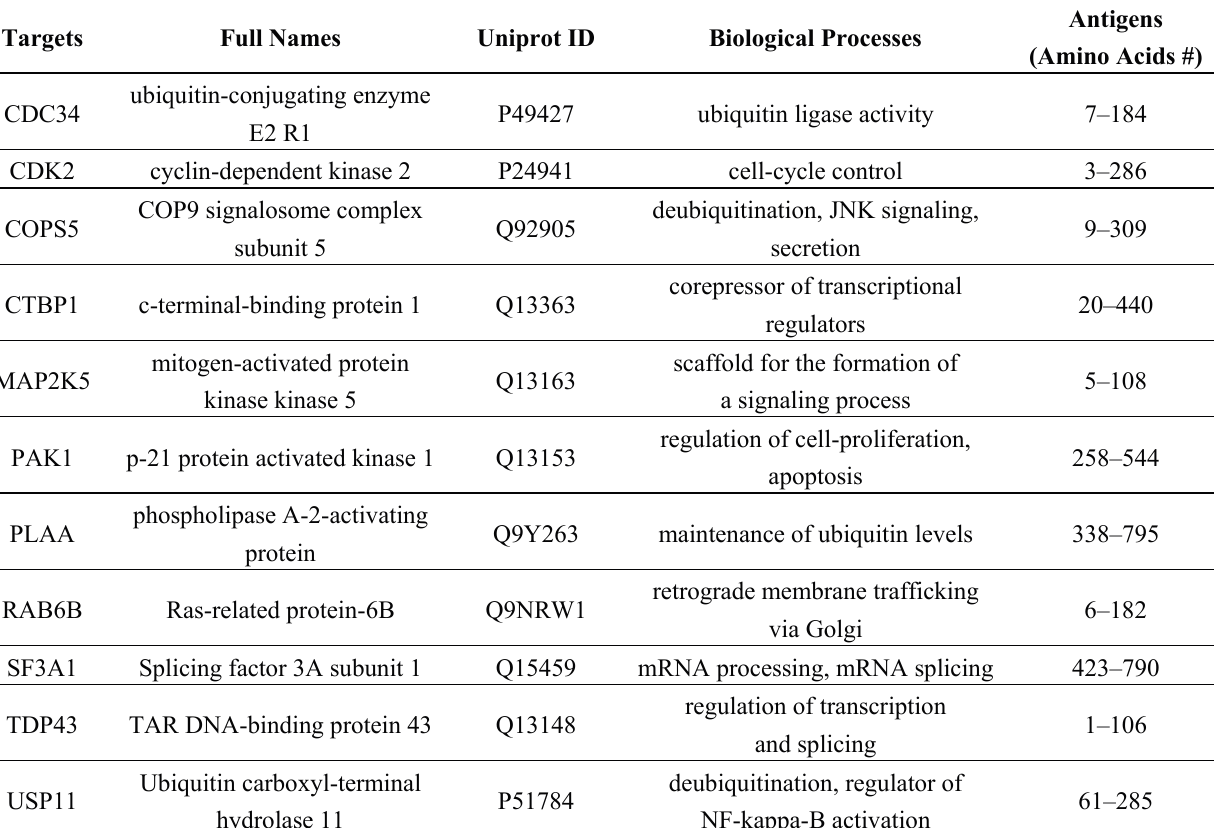
Figure 1. Integrating affinity maturation into the phage-display pipeline. ( A ) Schematic of the pipeline. After the target has been obtained, two rounds (Two black arrows) of phage-display affinity selection are performed, followed by creation of a secondary library via mutagenesis (A blue arrow). The resulting secondary library is then affinity selected for another three rounds (Three red arrows) to isolate individual clones that bind the target; ( B ) Competition polyclonal enzyme-linked immunosorbent assay (ELISA) illustrating the overall improvement in affinity of virion pool of post-maturation. The blue arrow indicates the mutagenesis process. Table 1. Eleven recombinant human antigens for affinity